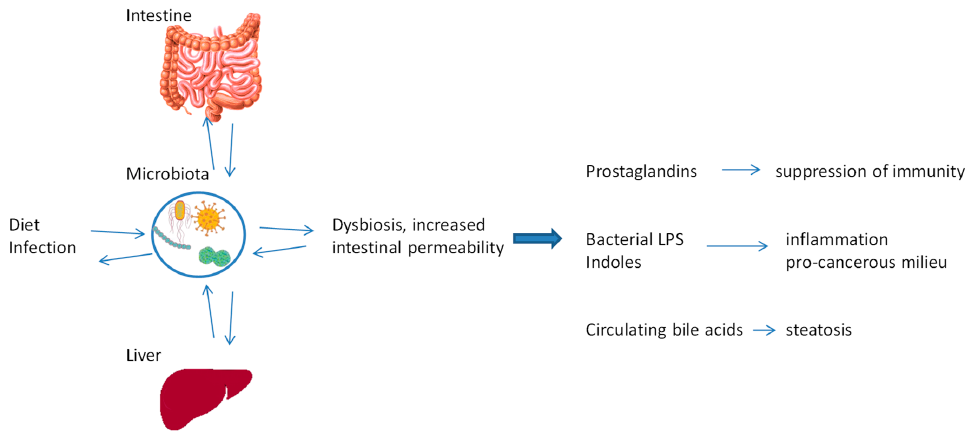
Figure 4. The gut–liver axis. The gut microbiota exacerbates liver diseases by: (i) the production of prostaglandins which suppress tumour immunity; (ii) the translocation of bacterial lipopolysaccharides (LPS) and other metabolites, particularly indoles, to the liver and other organs during states of high intestinal permeability; and (iii) the alterations of bile acid composition, leading to the accumulation of secondary bile acids in the liver.